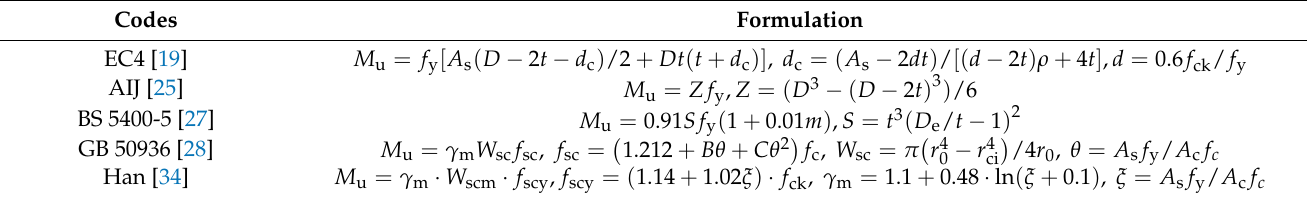
Table 9. Design formulas for the ultimate strength of CFST under